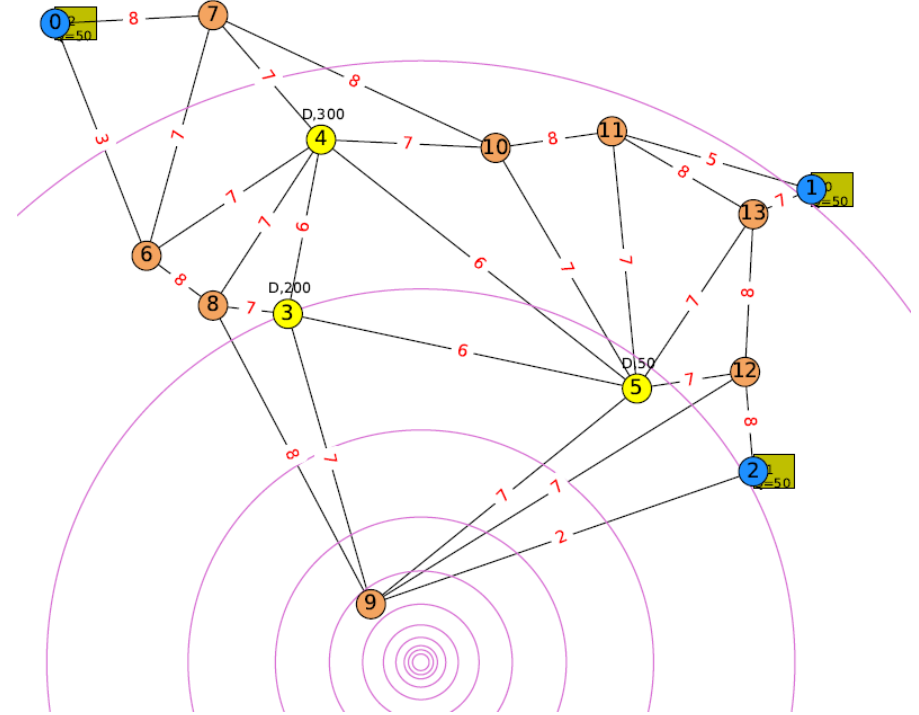
Figure A1. Road Network for Instance D3N8S3.